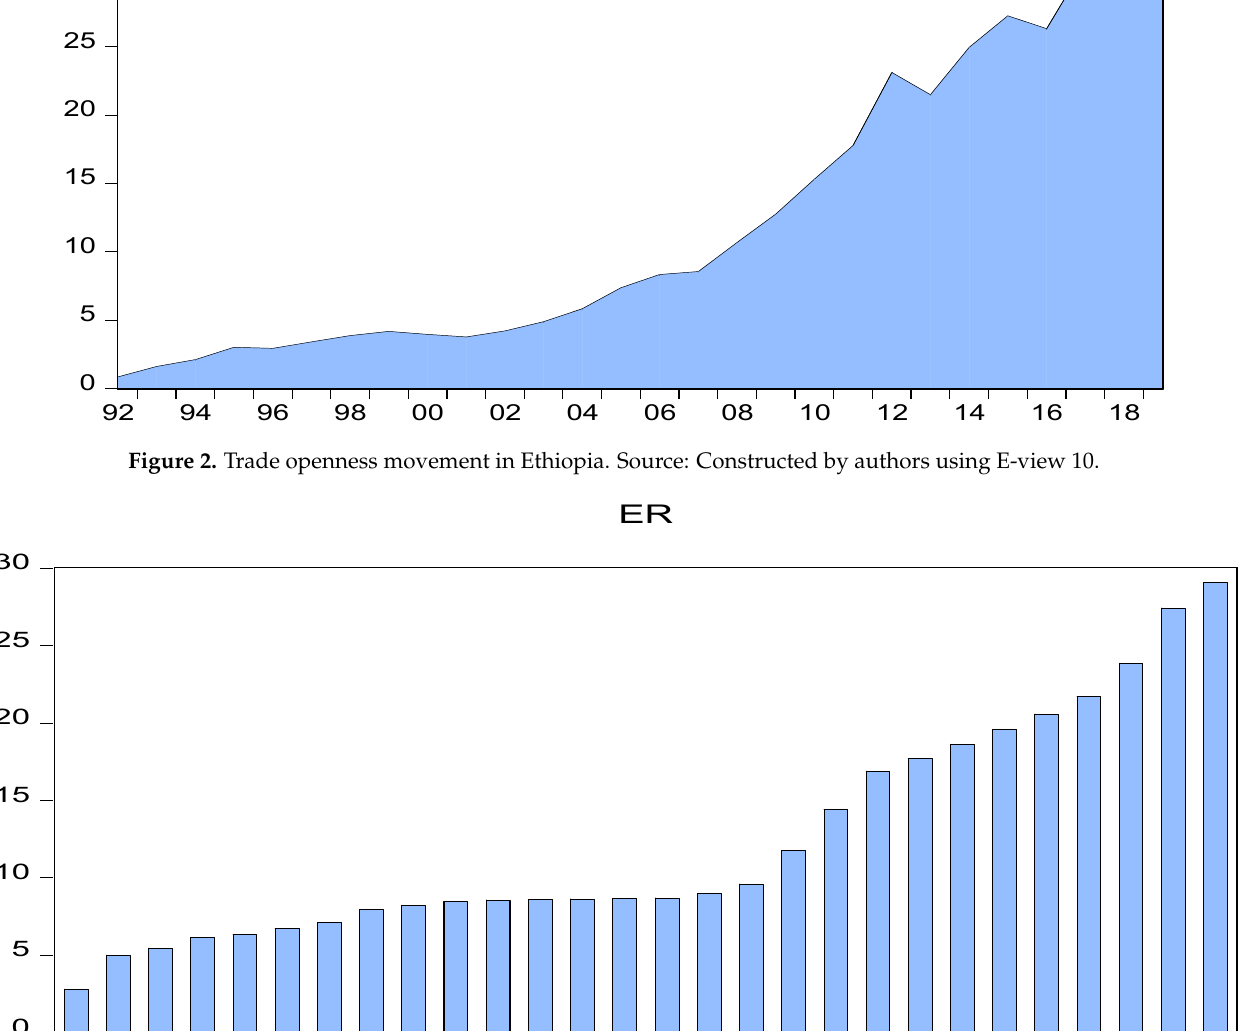
Figure 2. Trade openness movement in Ethiopia. Source: Constructed by authors using E-view 10.